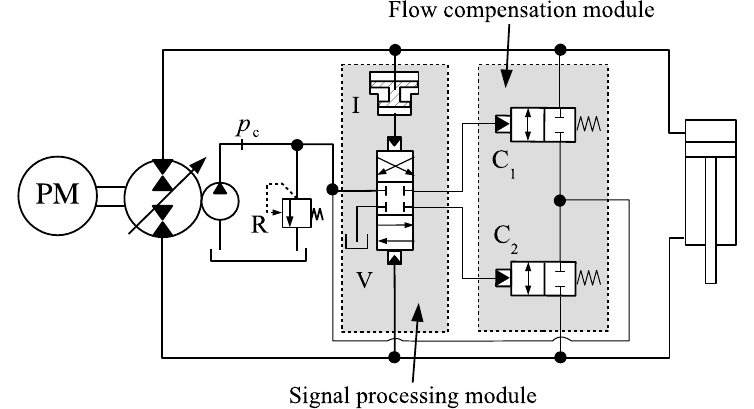
Figure 31. Circuit with logic-controlled flow compensation using hydraulic hardware.